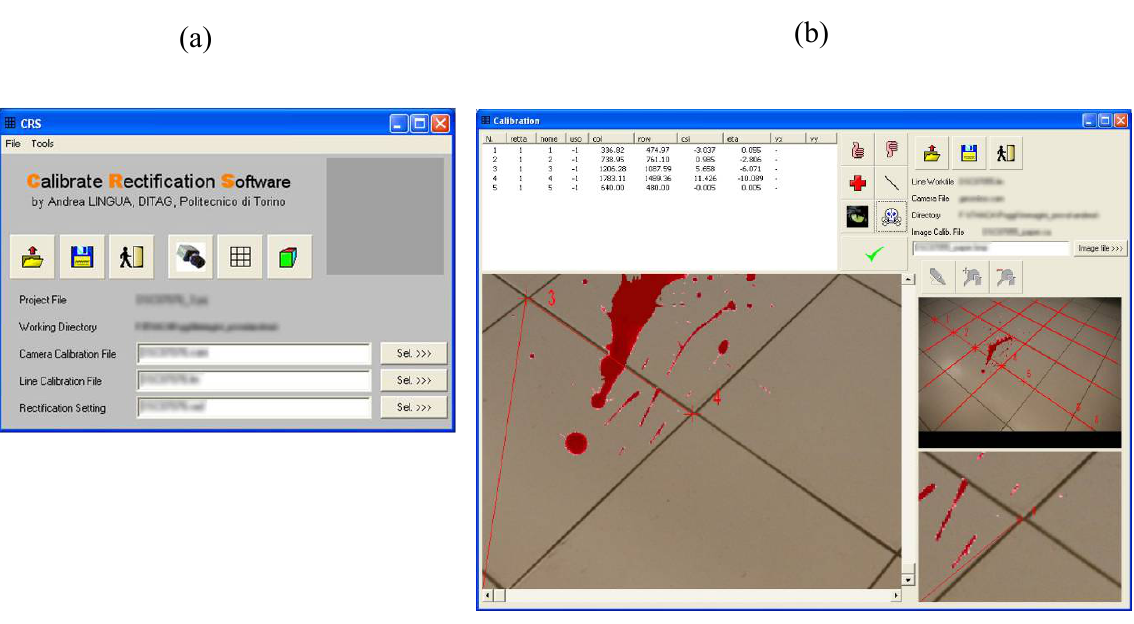
Figure 5. (a) The main window of the developed software CRS; (b) The CRS calibration module: straight lines identification.